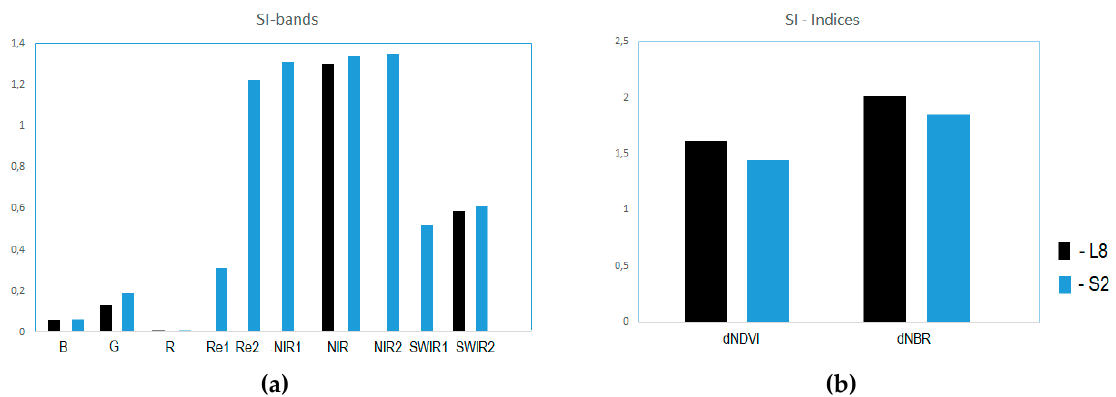
Figure 3. Separability analysis for Sentinel 2A and Landsat 8, considering the Arouca municipality: ( a ) considered sensor’s original bands; and ( b ) dNDVI and dNBR.